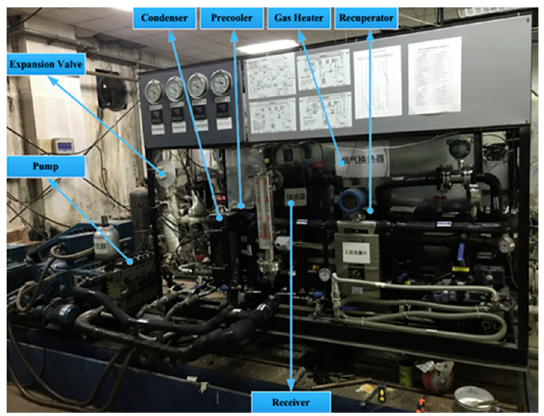
Figure 3. Experimental diesel engine and waste heat recovery system.